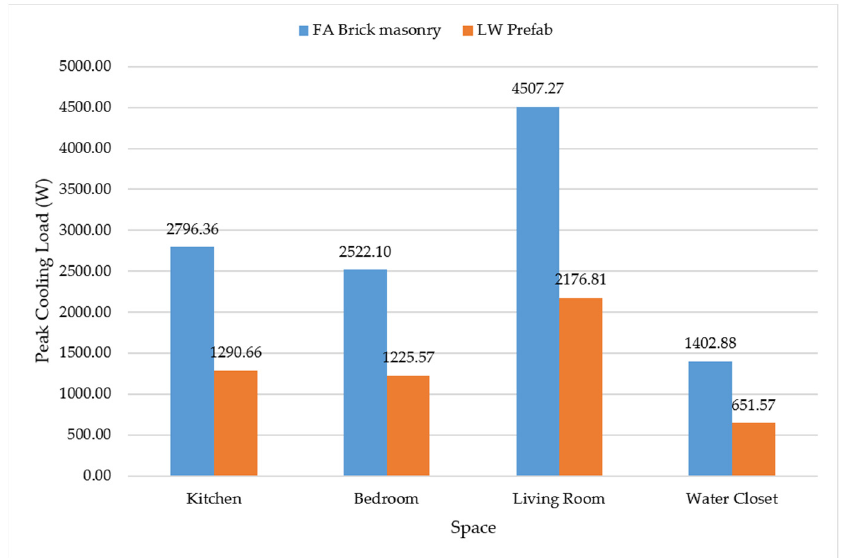
Figure 16. Comparison of peak cooling loads of two systems.